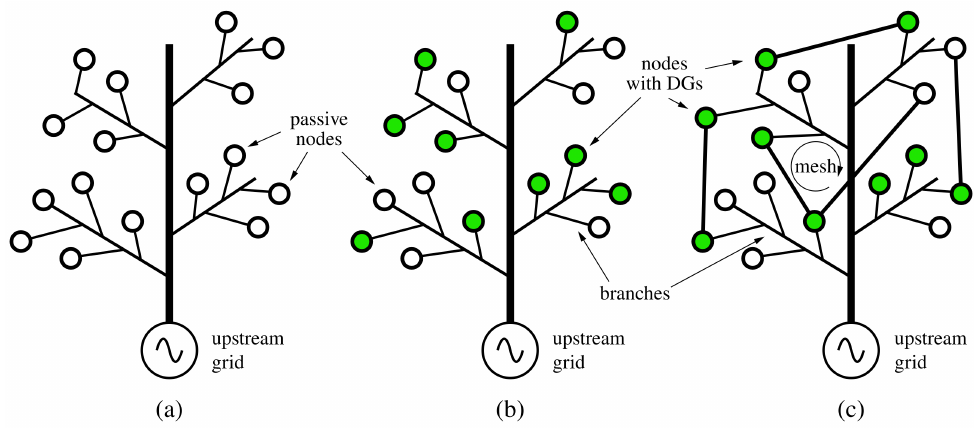
Figure 1. Different kinds of distribution networks. ( a ) Radial with passive nodes; ( b ) radial with distributed generators (DGs); ( c ) meshed with